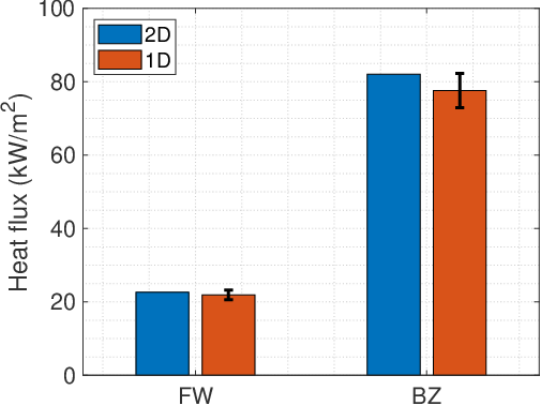
Figure 11. Heat flux across the FW and BZ resistances as computed by the 1D and 2D models. (The error on the 2D results is negligible and thus not shown.).